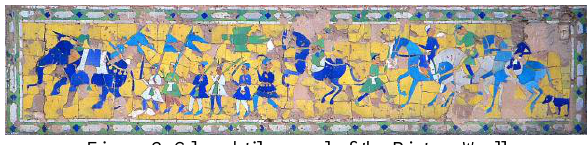
Figure 2. Glazed tile mural of the Picture Wall